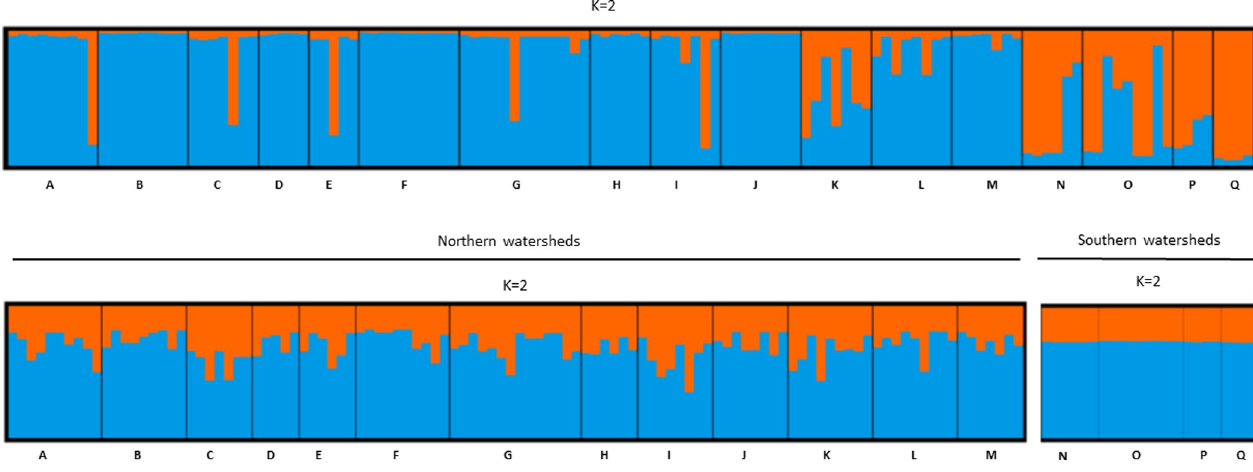
Fig 6. STRUCTURE analysis demonstrating the most likely number of clusters ( K ) using the “locprior” function for 16 populations in the Californian data set C based on 6 cpSSR markers and two separately analysed groups; 12 northern populations ( K = 3) and four southern populations located to the north or south of the San Francisco Bay, respectively ( K =